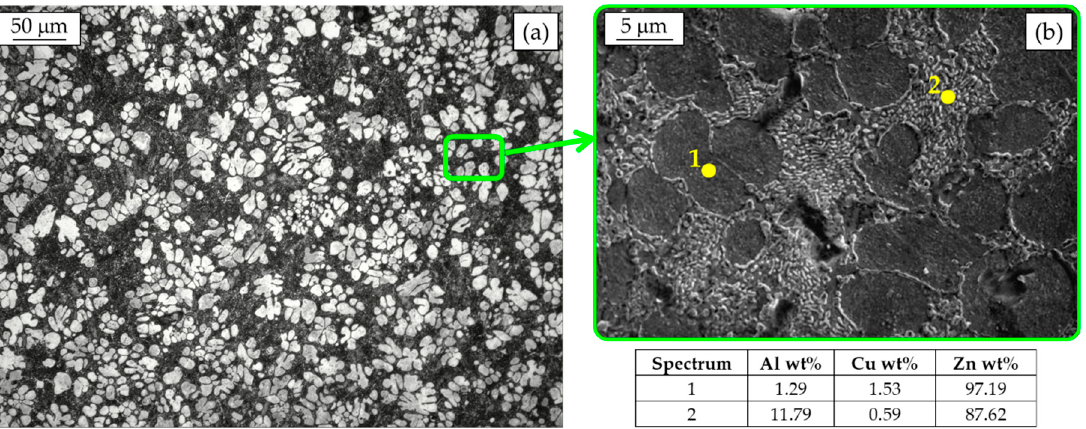
Figure 3. Hypoeutectic Zamak 5 microstructure ( a ) and SEM-EDS analysis ( b ) .